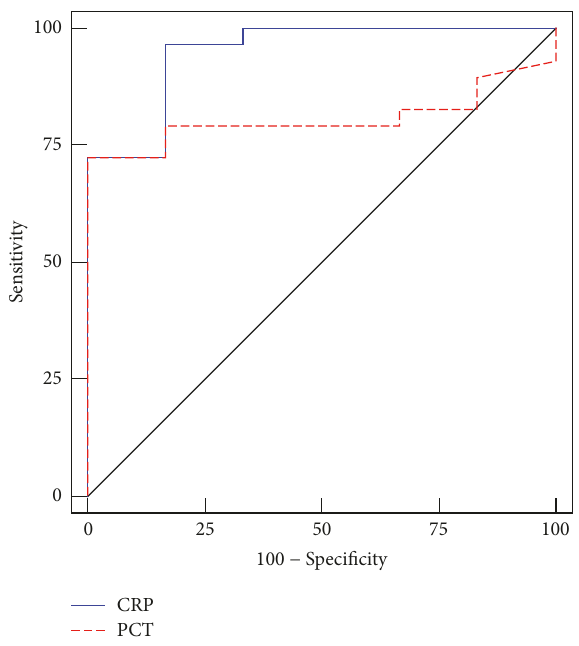
Figure 1: Using receiver operating characteristic analysis, compari- son of C-reactive protein (CRP) and procalcitonin (PCT) in acute- on-chronic liver failure patients with bacterial